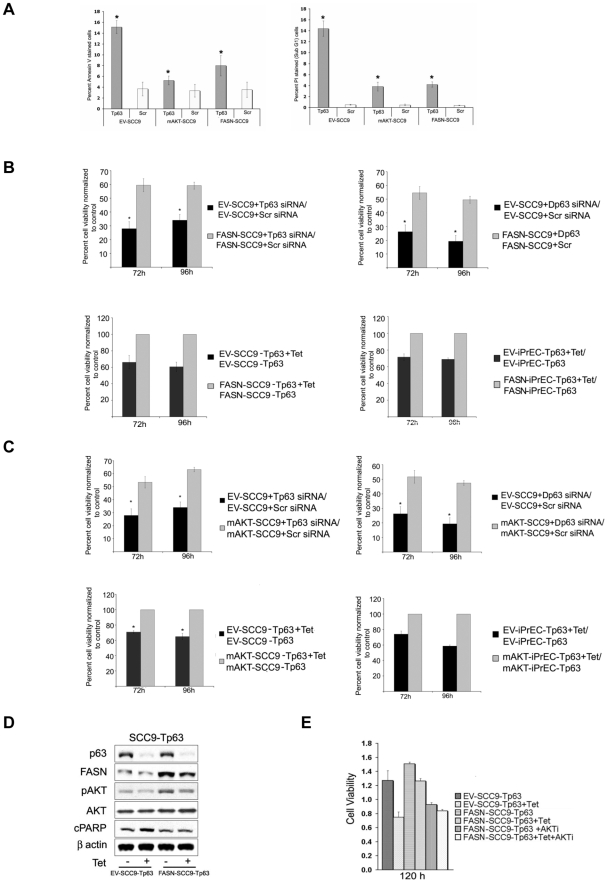
Increased FASN or AKT activity protects cells from apoptosis induced by p63 silencing.A. Quantitation of apoptosis by flow cytometry using Annexin V assay (left panel) or PI staining (right panel) in EV-SCC9, mAKT-SCC9, and FASN-SCC9 cells transfected with either Tp63 or Scr siRNAs. B. Effects of p63 silencing on the viability of SCC9 and iPrEC cells overexpressing either FASN or empty vector. Upper panels: Quantification of cell viability in EV-SCC9 and FASN-SCC9 cells transfected with either Tp63 (left panel) or Dp63 (right panel) relative to cells transfected with Scr siRNA. Lower left panel: Quantification of cell viability in EV-SCC9 and FASN-SCC9 cells carrying inducible Tp63 shRNA (EV-SCC9-Tp63 and FASN-SCC9-Tp63) treated with tetracycline relative to untreated cells. Lower right panel: Quantification of cell viability in EV-iPrEC and FASN- iPrEC cells carrying inducible Tp63 shRNA (EV-iPrEC-Tp63 and FASN- iPrEC-Tp63) treated with tetracycline relative to untreated cells. C. Effects of p63 silencing on the viability of SCC9 and iPrEC cells overexpressing either Myr-AKT or empty vector. Upper panels: Quantification of cell viability in EV-SCC9 and mAKT-SCC9 cells transfected with either Tp63 (left panel) or Dp63 (right panel) relative to cells transfected with Scr siRNA. Lower left panel: Quantification of cell viability in EV-SCC9 and mAKT-SCC9 cells carrying inducible Tp63 shRNA (EV-SCC9-Tp63 and FASN-SCC9-Tp63) treated with tetracycline relative to untreated cells. Lower right panel: Quantification of cell viability in EV-iPrEC and mAKT-iPrEC cells carrying inducible Tp63 shRNA (EV-iPrEC-Tp63 and mAKT-iPrEC-Tp63) treated with tetracycline relative to untreated cells. Data are shown as means +/− standard error and are representative of three independent experiments. D. Immunoblot analysis of p63, FASN, phospho-AKT and c-PARP in EV-SCC9-Tp63 and FASN-SCC9-Tp63 cells with or without treatment with tetracycline. E. Inhibition of AKT signaling significantly affects FASN-mediated rescue of cell death induced by p63 silencing. The graph shows the viability of EV-SCC9-Tp63 with or without treatment with tetracycline and of FASN-SCC9-Tp63 and FASN-SCC9-Tp63 cells with or without treatment with an AKT inhibitor and/or tetracycline. Data are shown as means +/− standard error and are representative of three independent experiments.